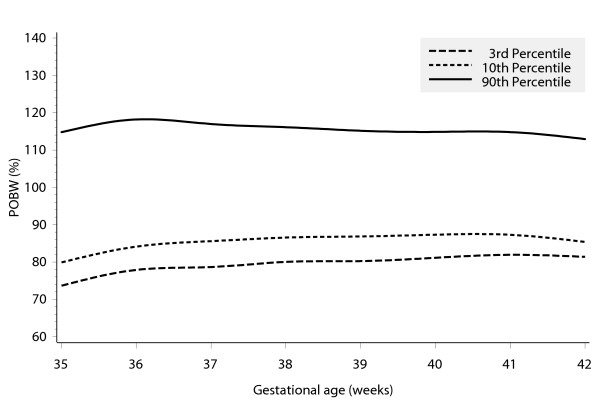
Weighted mean POBW (across 8 parity/gender combinations) observed at the 3rd, 10th and 90th percentile positions on the birth weight distributions, by gestational age at delivery.